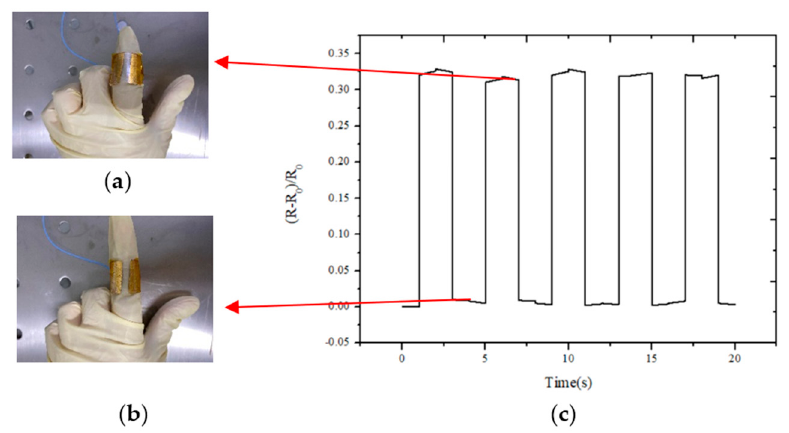
Figure 13. ( a ) Joint bending state; ( b ) joint straight state; ( c ) resistance output performance test of bilayer graphene sensor fixed at the finger joint.